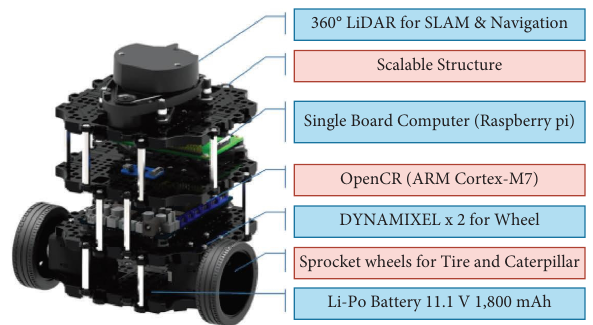
Figure 2: Te TurtleBot3 Burger.